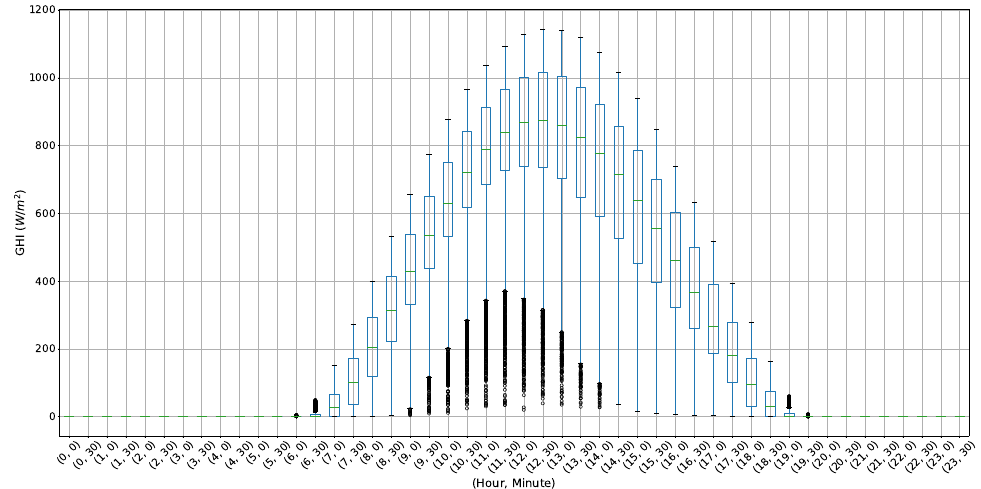
Figure 4. Boxplot of GHI for every intra-day time step from 2007 to 2019.